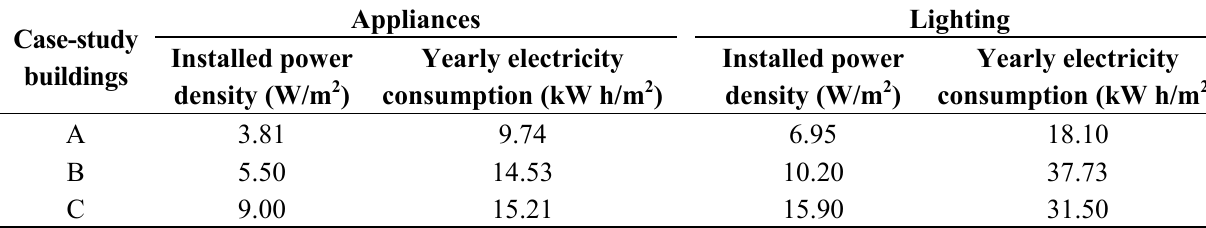
Table 5. Resulting installed power density and yearly electricity consumption for appliances and lighting in the case-study buildings [10,11].